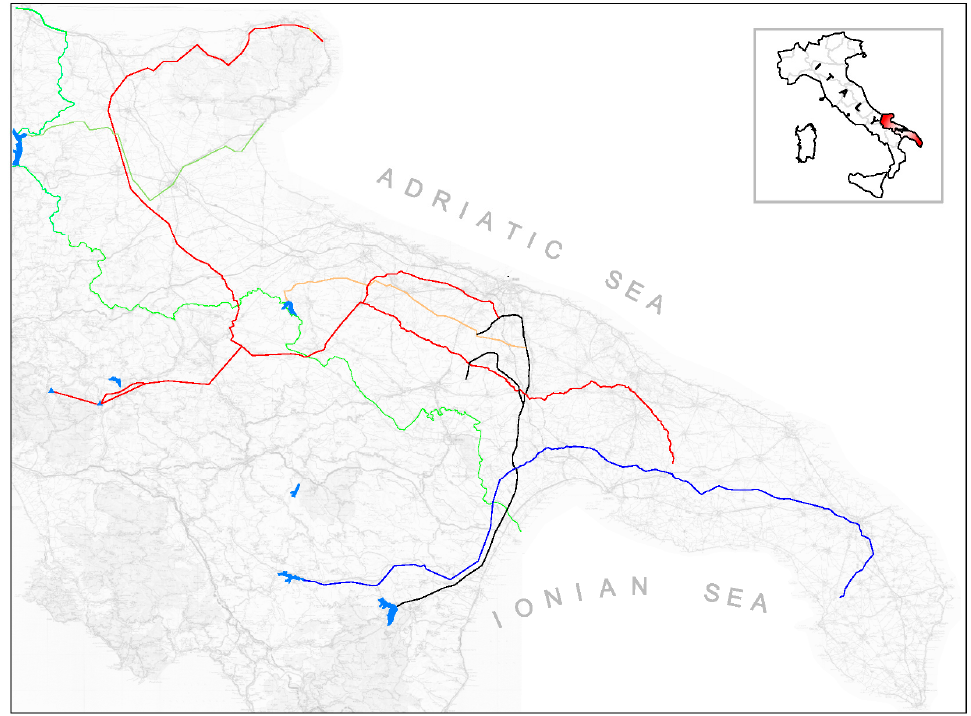
Figure 1. The AQP water supply network.